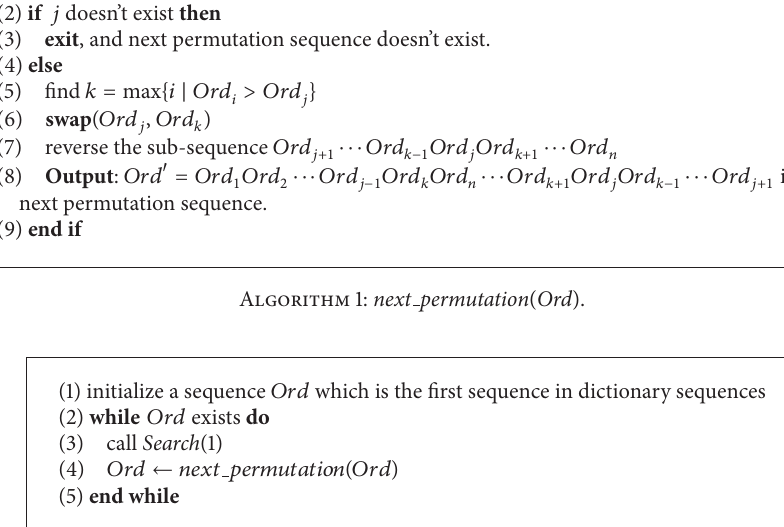
Algorithm 2: Dictionary sequence enumeration